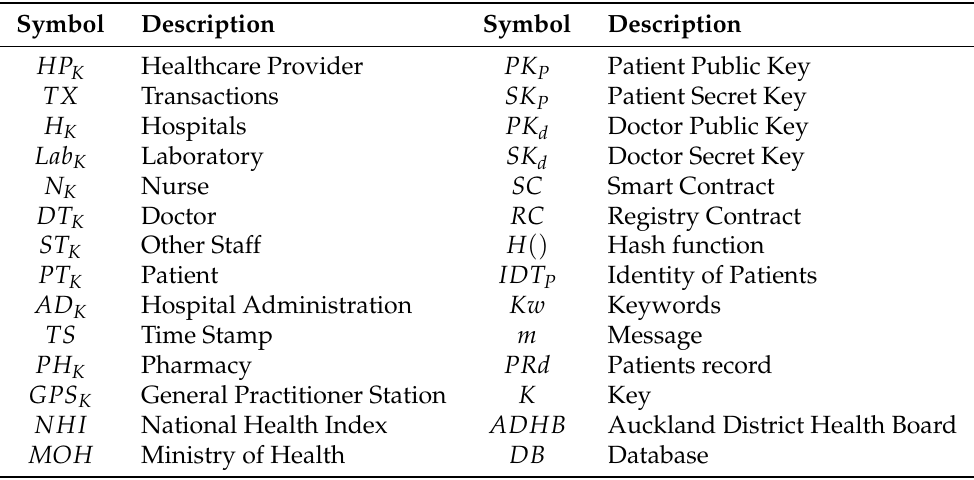
Table 1. Notations used in the BlockPres